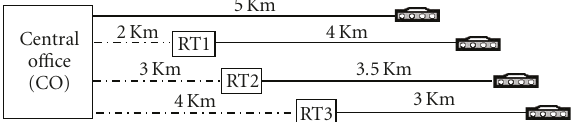
Figure 4: DSL scenario with 2-user ( N = L =